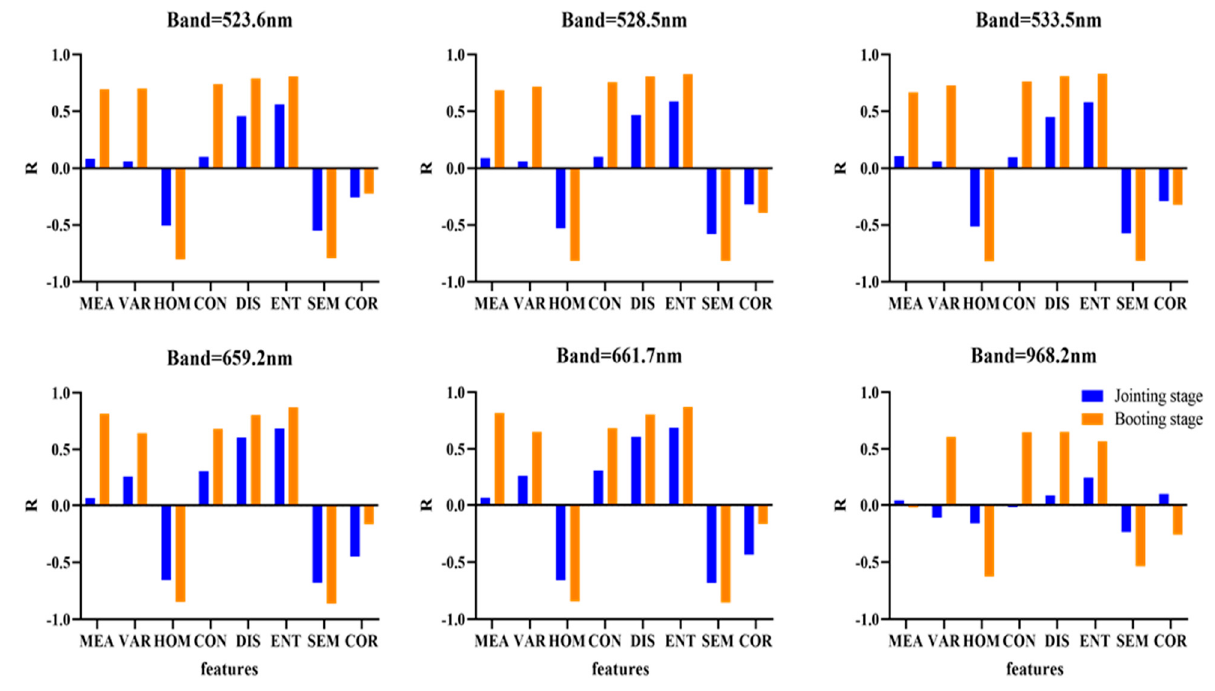
Figure 7. Pearson correlation analysis between texture features and DS.